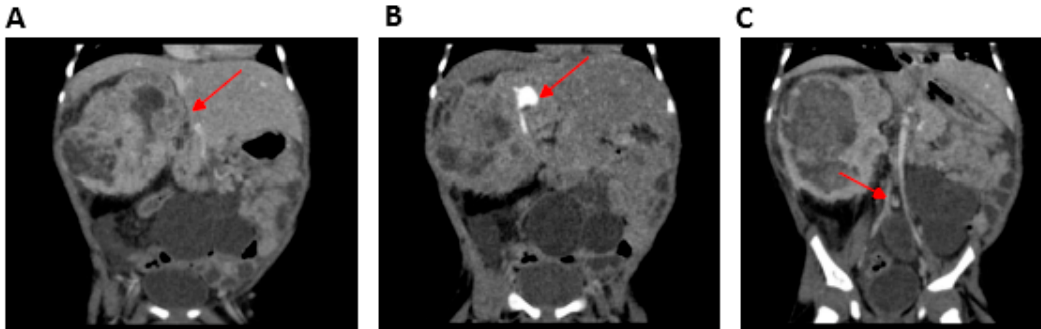
Figure 2. Computerized tomography (CT) urogramof Patient 2 (P2) (performed after vincristine therapy and before surgery). ( A ) Mesoblastic nephroma located in the right kidney (arrow), ( B ) contrast-enhanced portion of the functioning right kidney located in the superior pole of the nephroma (arrow) without a cleavage plane, and ( C ) multicystic left kidney (arrow).